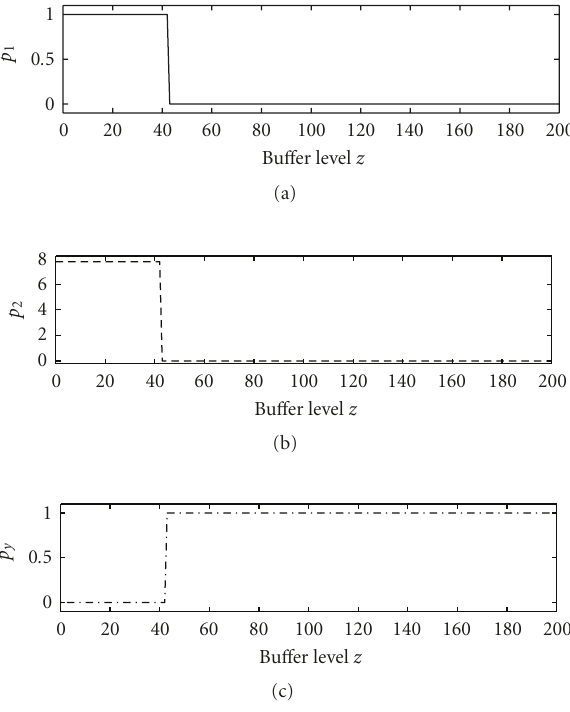
Figure 12: Power allocation as a function of z and channel state